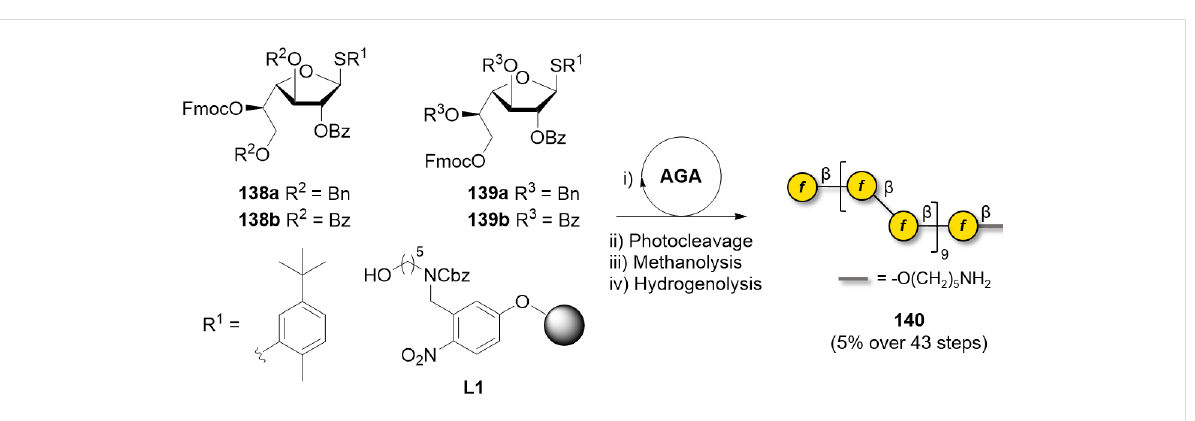
Scheme 18: AGA of a linear β (1–5) and β (1–6)-linked galactan 20mer. The AGA cycle includes coupling (NIS/TfOH), capping (Ac 2 O) and Fmoc deprotection (DBU).